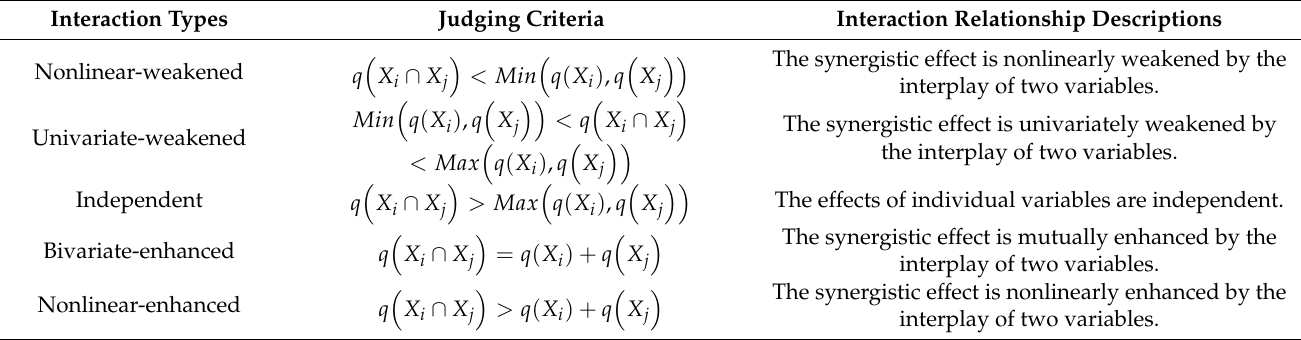
Table 1. Definition of the interaction types in the GeoDetector model